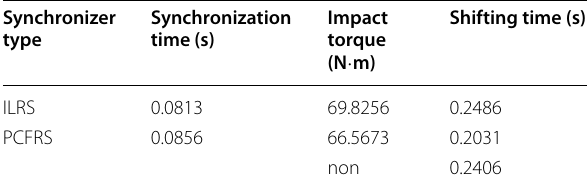
Table 2 Simulation data comparison between ILRS and